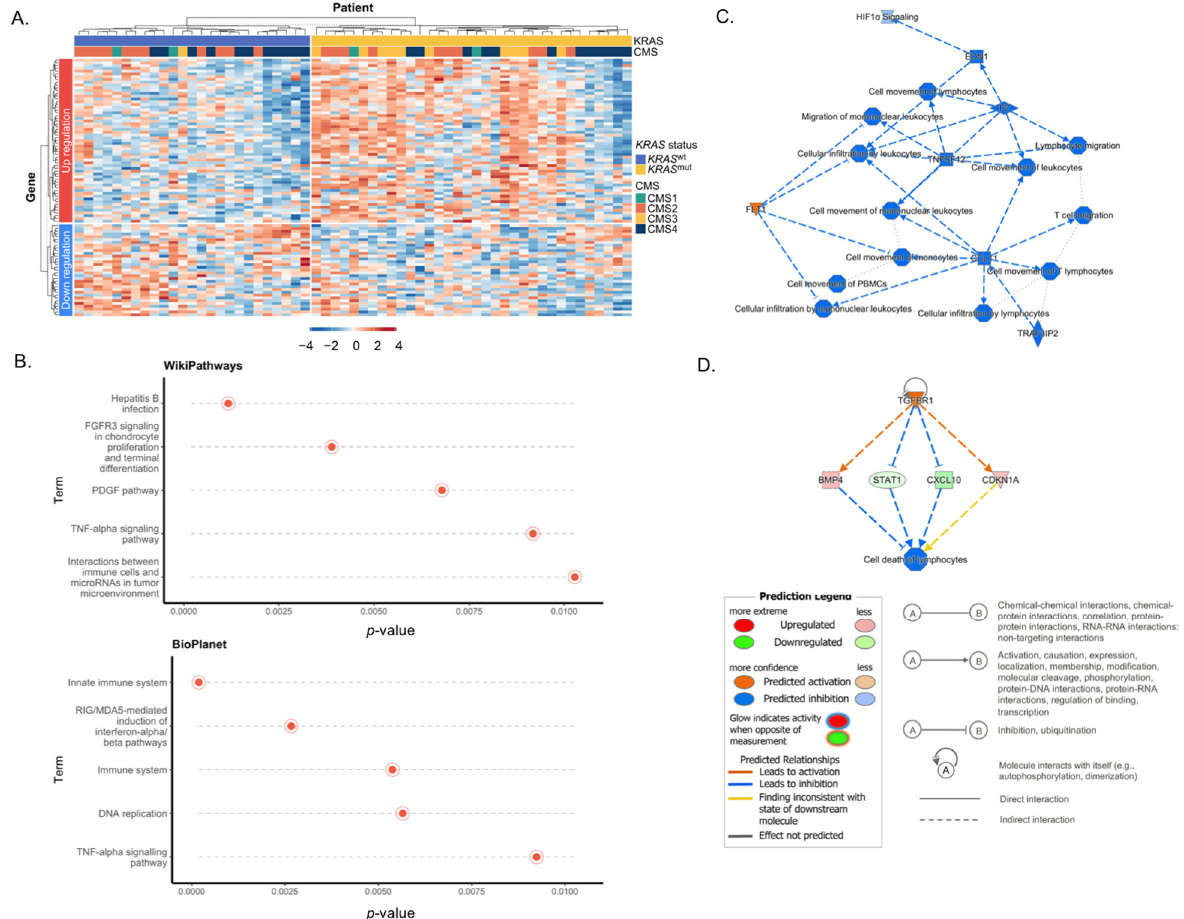
Figure 2. Differential gene expression between KRAS mut and KRAS wt with a p -value < 0.05. ( A ) Heatmap for 92 DEGs of KRAS mut (rows) from the NanoString PanCancer progression panel are clustered by statistically significant downregulation (blue) and up regulation (red) between KRAS mut and KRAS wt (column). The consensus molecular subtypes 1–4 (CMS1–4) were also clustered (column). Blue to red denotes gene expression, with blue implying low gene expression and red implying high gene expression. ( B ) Top five pathways of BioPlanet and WikiPathways database sources enriched by DEGs with their FDR values. ( C ) The IPA graphical summary of 92 statistically significant DEG of KRAS mut . ( D ) The IPA upstream regulator analysis reveal that TGFBR1 is the upstream regulator associated with lymphocyte cell death.